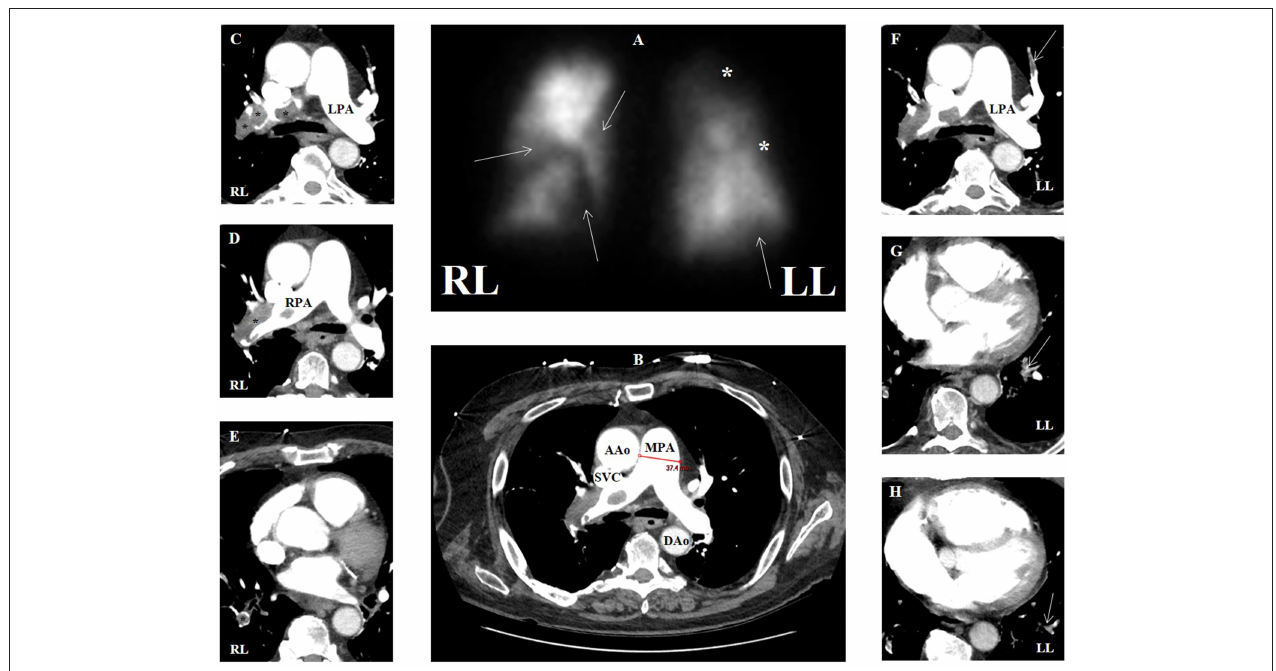
FIGURE 9 | (A) Ventilation-perfusion scan in a patient with group 4 pulmonary hypertension with multiple segmental defects (arrows) and additional areas of possible defect (asterisks), overall with high probability for pulmonary embolism. (B) Contrasted computed tomographic angiography (CTA) in transaxial view of same patient showing main pulmonary artery dilation (3.7cm) compatible with pulmonary hypertension. (C–E) CTA showing multiple areas of filling defect consistent with pulmonary emboli (asterisks) that correspond to perfusion defects in the right lung. (F–H) CTA showing multiple areas of filling defect compatible with pulmonary emboli (arrows) that may correspond to perfusion defects in the left lung. AAo, ascending aorta; DAo, descending aorta; LL, left lung; LPA, left pulmonary artery; MPA, main pulmonary artery; RL, right lung; RPA, right pulmonary artery; SVC, superior vena